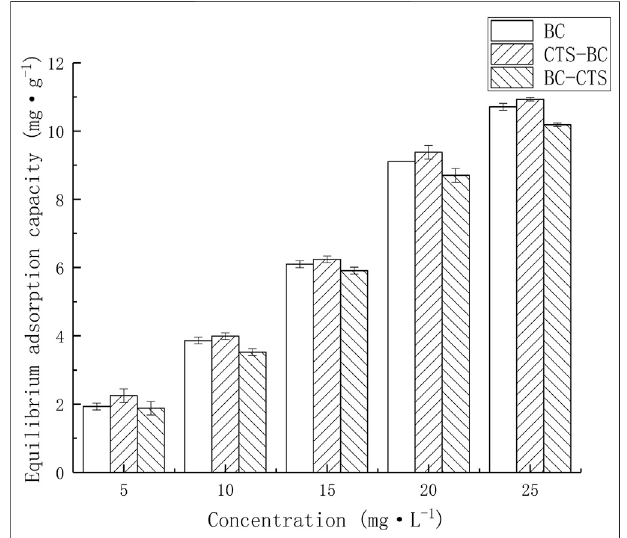
FIGURE 1 | Effect of initial concentration on Pb 2+